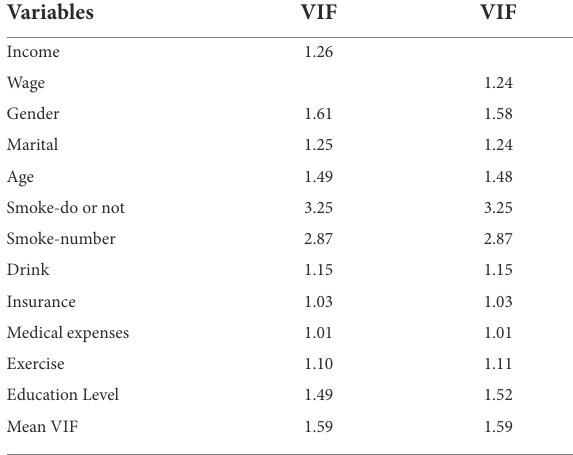
TABLE 2 The variance inflation factor of each variable. TABLE 3 OLS results of the effects of income on mental